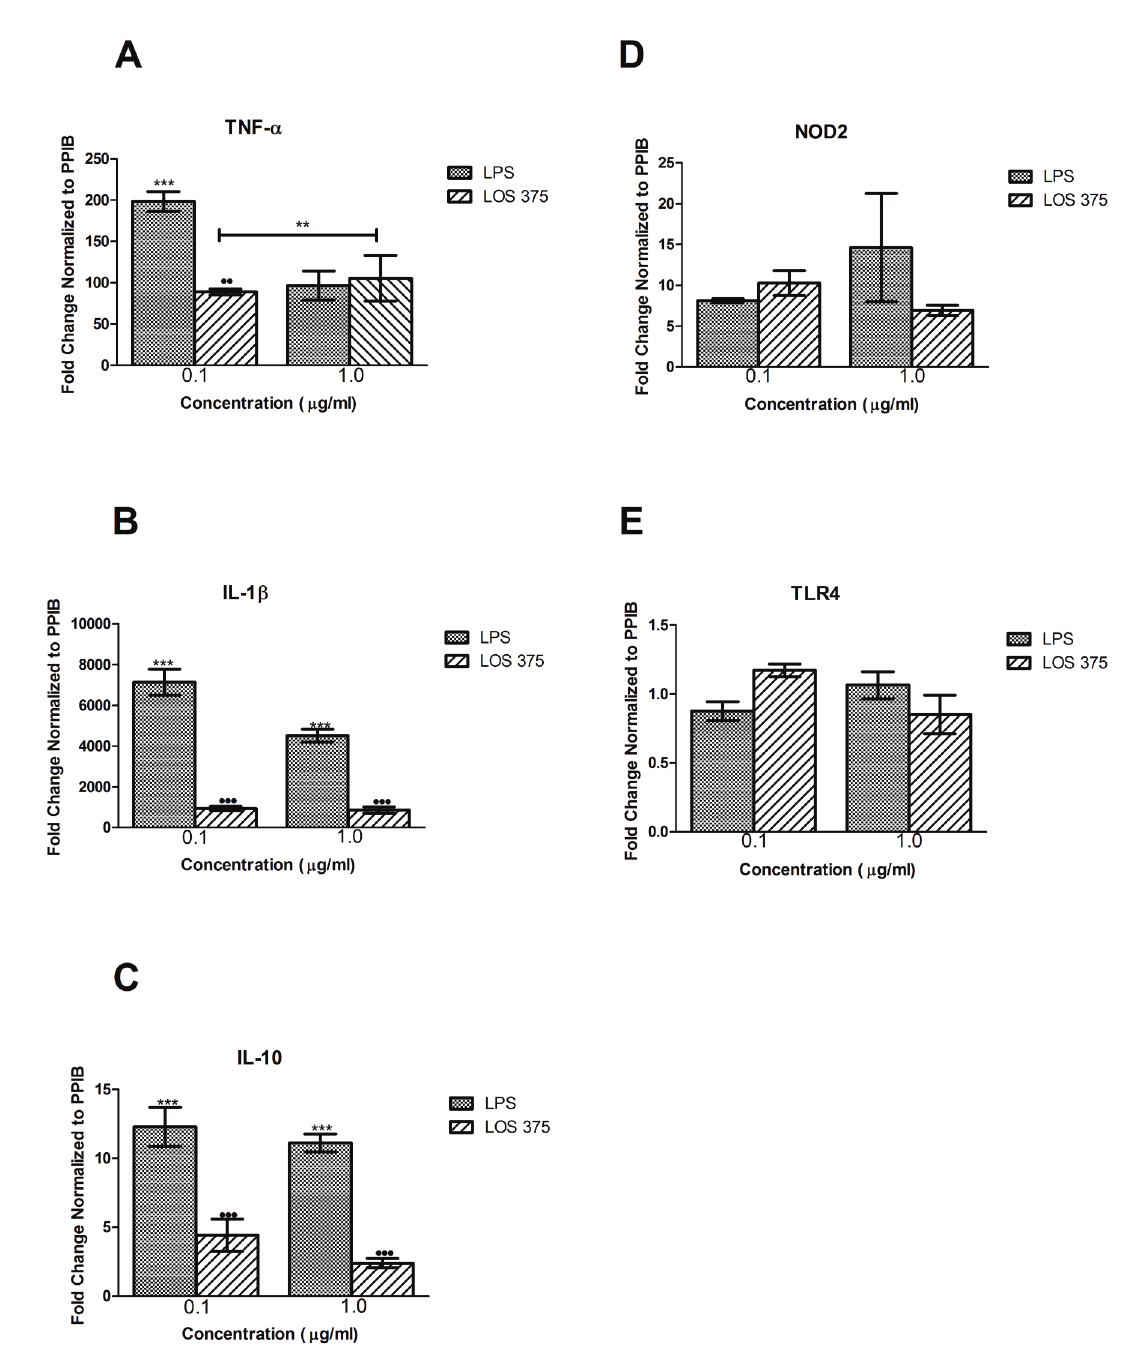
Figure 2. Gene expression analysis for THP-1 cells stimulated with NTHi LOS or E. coli LPS. THP-1 cells were stimulated with either LPS or LOS at 0.1 and 1 µ g/ml for 4 hours. Following RNA extraction, gene expression of TNF- α (A), IL-1 β (B), IL-10 (C), NOD2 (D), and TLR4 (E) was studied using real-time PCR. Data are displayed as the fold change relative to the unstimulated control. Data represent means ± • SEM (n = 3). *, P < 0.05 compared to unstimulated control; , P < 0.05 between LPS and